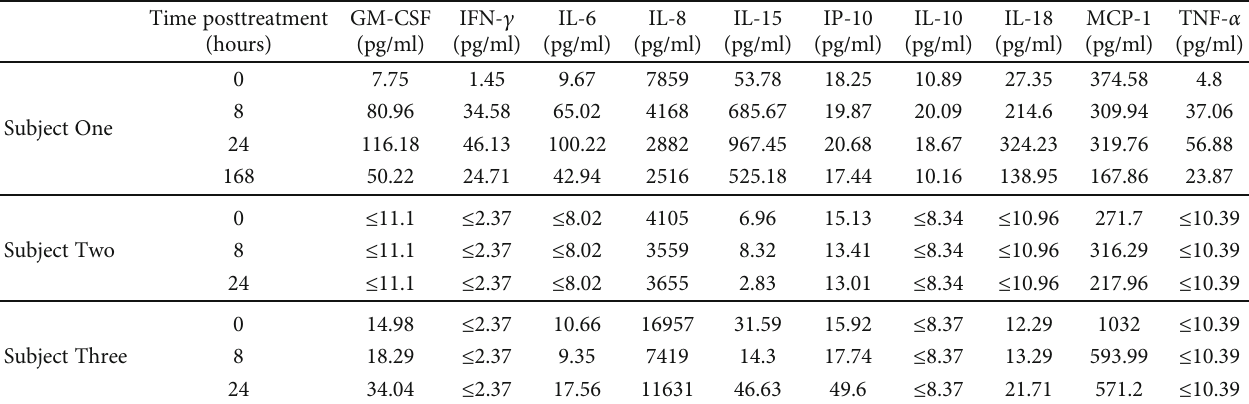
Table 1: Results from cytokine analysis of blood samples from three study subjects at various time intervals postadministration of Innocell product. Results include data for immune system-related (GM-CSF, IFN- γ , IL-6, IL-8, IL-15, IP-10, IL-10, TNF- α , and IL-18) and tumor-related (IL-8 and MCP-1)